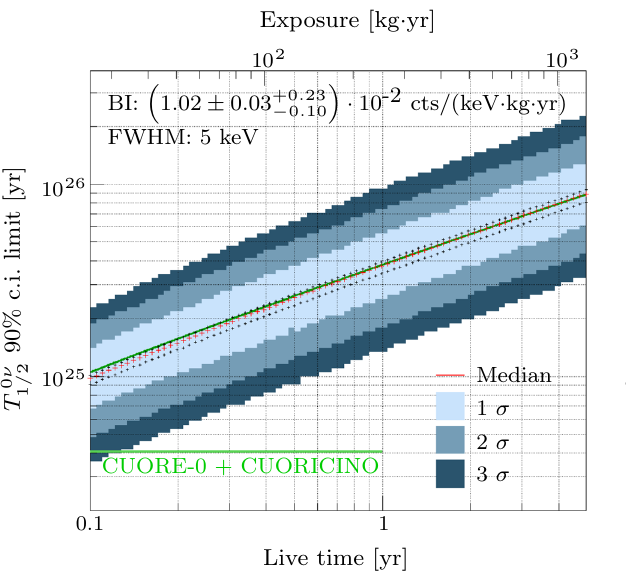
Fig. 2 90% CI exclusion sensitivity for a 5keV ( left ) and a 10keV FWHM ( right ). The red crosses correspond to the median sensitivity for a BI of 10- 2 cts /( keV · kg · yr ) , while the smaller black crosses cor- respond to the median sensitivity obtained after shifting the BI up and down by an amount equivalent to its statistical and systematic uncertainty summed in quadrature. The uncertainty on BI yields a + 4% −